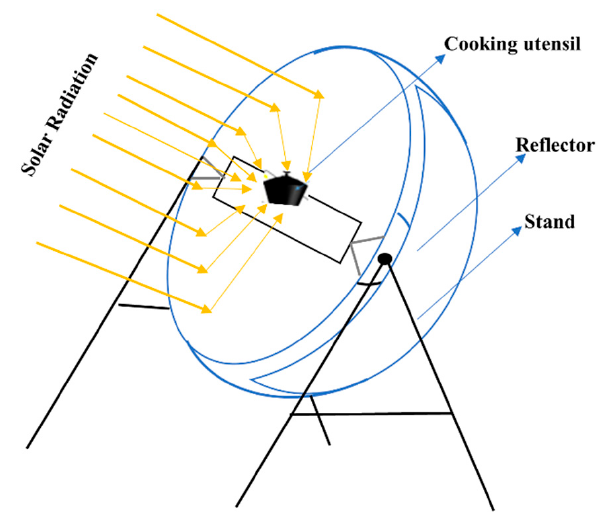
Figure 3. Concentrating solar